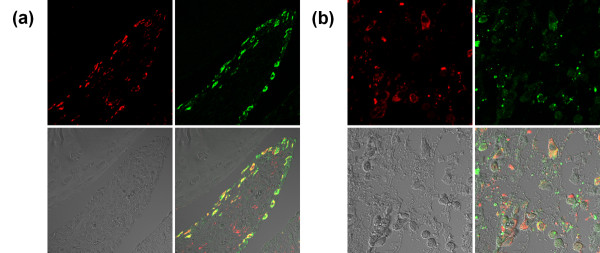
Immunohistochemical staining of sections from inflamed joints with anti-CD68 or anti-prolyl-4-hydroxylase antibodies. Representative confocal microscopic images of (a) anti-CD68 and (b) anti-prolyl-4-hydroxylase immunohistochemical staining of decalcified, Alexa Fluor® 488-labeled N-(2-hydroxypropyl)methacrylamide copolymer (P-Alexa)-treated adjuvant-induced arthritis (AA) rat ankle joint sections are summarized in this figure. Each panel is composed of four sub-images: antibody red staining, P-Alexa green signal, differential interference contrast (DIC) image and the co-localization of the three. The co-localization of red and green color in both panels yields a yellow color, which confirms the uptake of the HPMA copolymer conjugate by CD68-positive (macrophage-like) or prolyl-4-hydroxylase-positive (fibroblast-like) synoviocytes in AA rat ankle joints.